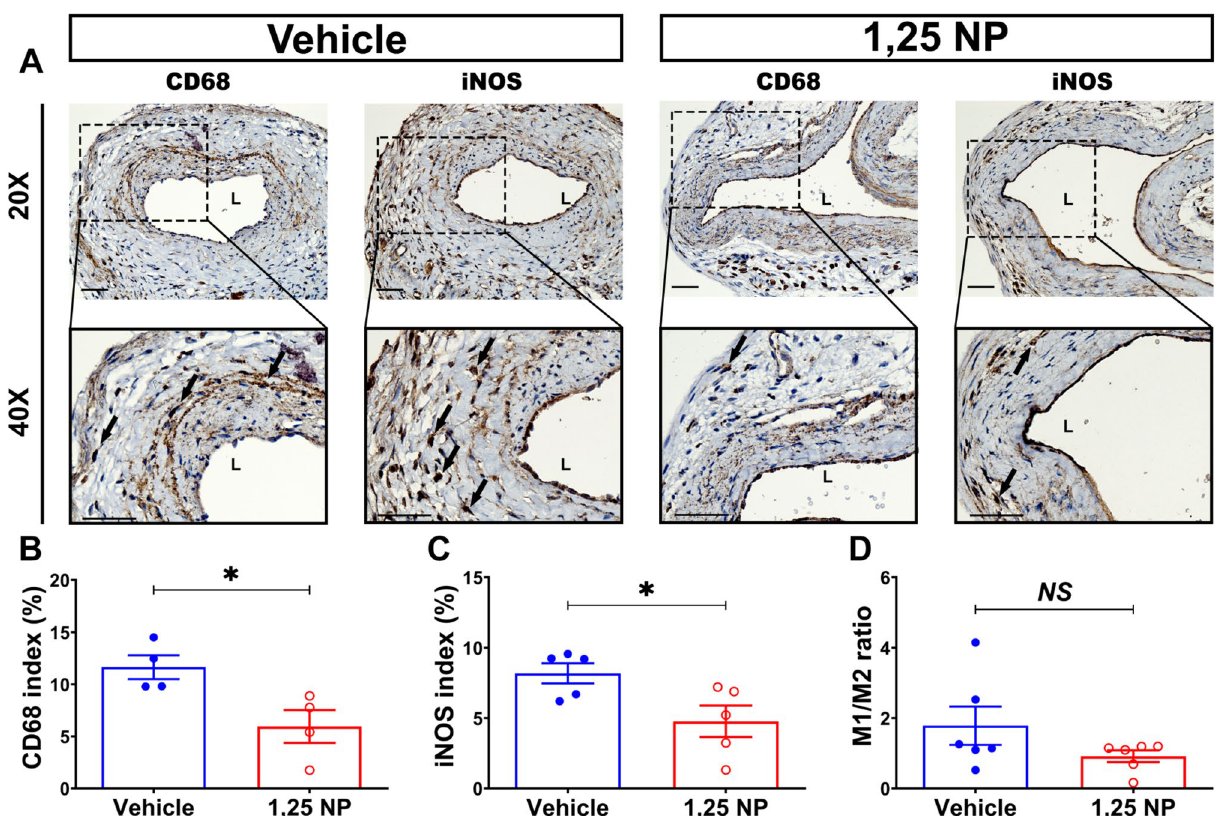
Figure 5. Inflammatory cells staining in 1,25 NP treated vessels. ( A ) Representative slides for negative control (IgG), CD68, and iNOS staining are shown in vehicle controls and 1,25 NP treated vessels. There is increased CD68 and iNOS (+) cells in the vessel controls compared to 1,25 NP treated vessels. ( B – D ) Semi-quantitative analysis showed a significant decrease in the average CD68 ( p < 0.05) and iNOS ( p < 0.05) indices, but no difference in the average M1/M2 ( p > 0.05) index in 1,25 NP treated vessels compared to vehicle controls. Each data point in the scatter plot bar graph represents the mean ± SEM of 4–6 AVF mice. Unpaired t- test was performed. Significant differences are indicated * p < 0.05. Cells staining positive for CD68 and iNOS staining are brown. ADV adventitia, L lumen; solid arrows, positive cells. Scale bar is 50